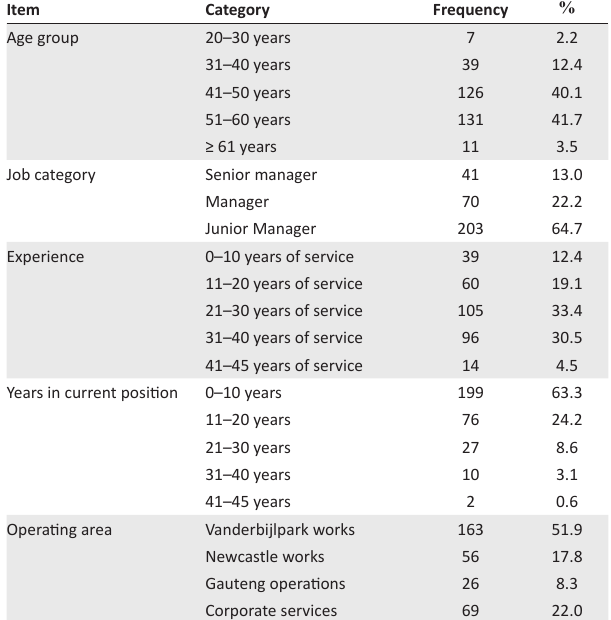
TABLE 1 : Characteristics of participants ( n =